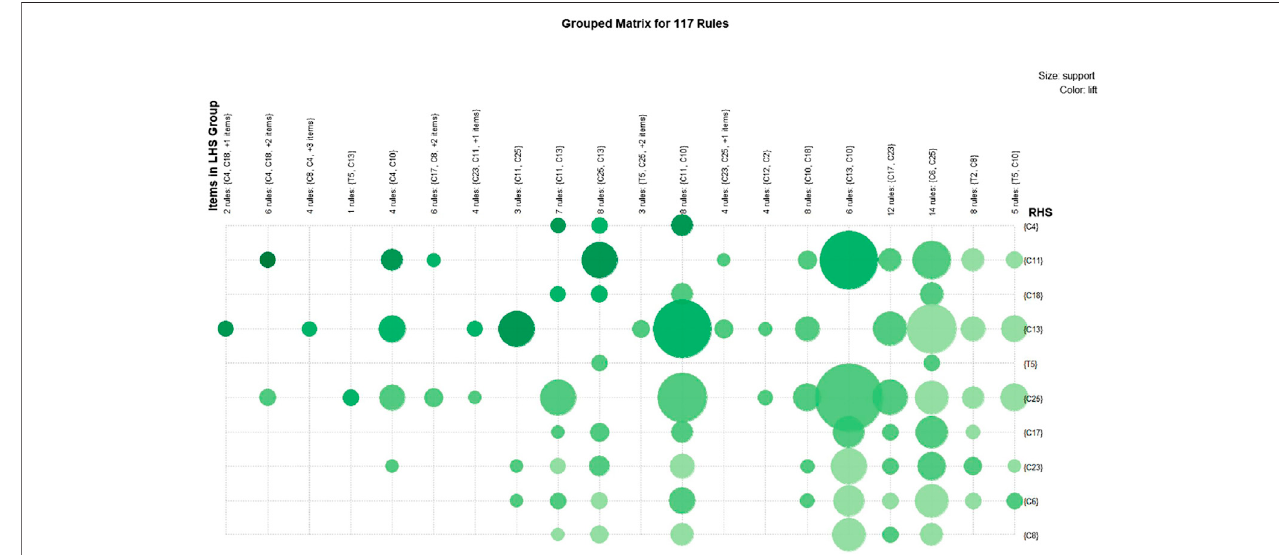
FIGURE 5 | Rule diagram based on the grouping